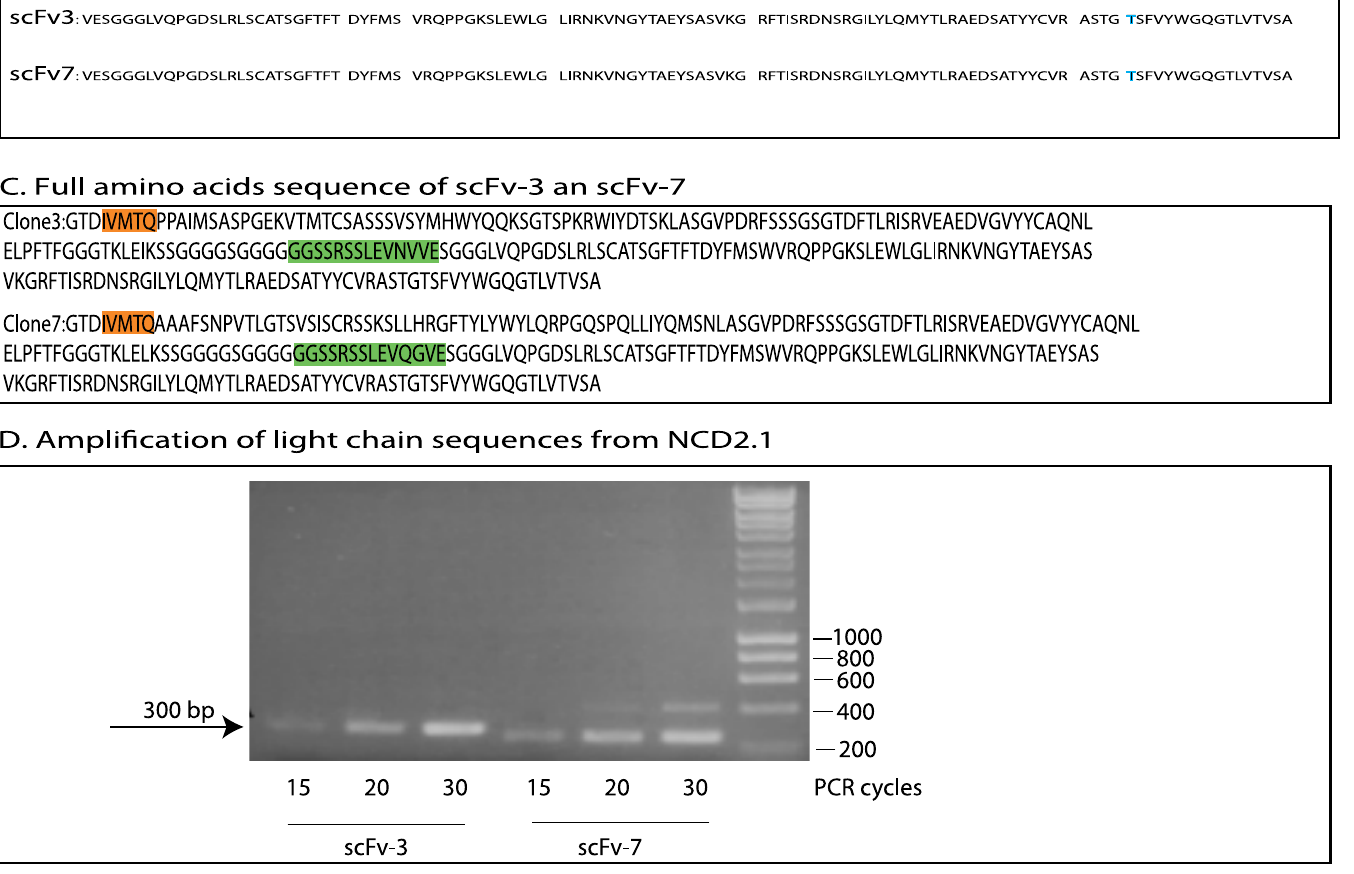
Fig 9. Amino acid sequences of scFv-3 and scFv-7. (A and B). The amino acid sequences of the light chain and heavy chain framework and CDR regions are as indicated. The CDRs of the light chain are highlighted in red, since the sequences diverge in CDR1 and CDR2 of the two light chains, but are identical in the CDR3 of the light chain. (C). The full amino acid sequence of scFv-3 and scFv-7 including the linker is highlighted. Based on the amino acid sequences, the scFv-3 and scFv-7 light chains could have been amplified using any of the primers 4,5,13, or 15 (Fig 7A (in orange)). The heavy chain amino acid sequences also represent different PCR amplicons but with identical CDRs; the scFv-3 heavy chain could have been amplified using primers 8, 9, or 15, highlighted in green (Fig 7B). The scFv-7 heavy chain could have been amplified using primers 8, 9, or 10, highlighted in green (Fig 7B). (D). RT-PCR was applied using primers directed to the divergent scFv-3 and scFv-7 light chains (from the divergent CDR1 sequences (in red) to Framework 4) expressing from the NCD1.2 hybridoma cell line to establish that the light chain mRNA for scFv-3 and scFv-7 are both expressed to similar levels, as defined by the amount of PCR products after 15, 20, or 30 PCR cycles. The size of the CDR1-FR4 PCR product is approximately 300 bp and the 200 bp ladder is Hyperladder (Bioline). These data indicate that the hybridoma produces two light chains with an identical CDR3.